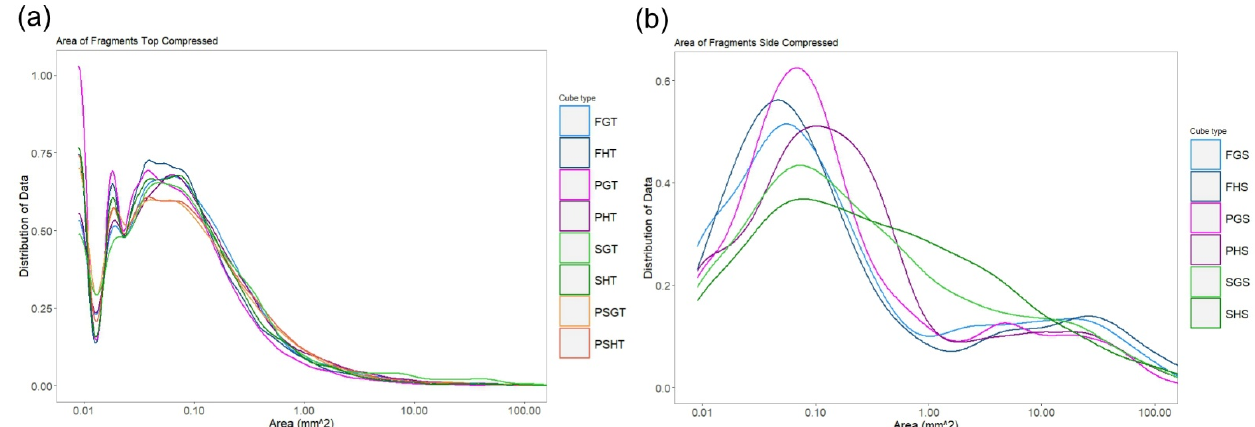
Figure 3. Density diagrams showing size distribution of areal size of fragments after Textural analyser (TA) ( a ) from the top and ( b ) from the side. F Fibre-rich, P Protein-rich, S Starch-rich, PS protein- and starch-rich, G Grid, H honeycomb, T Top, S side.